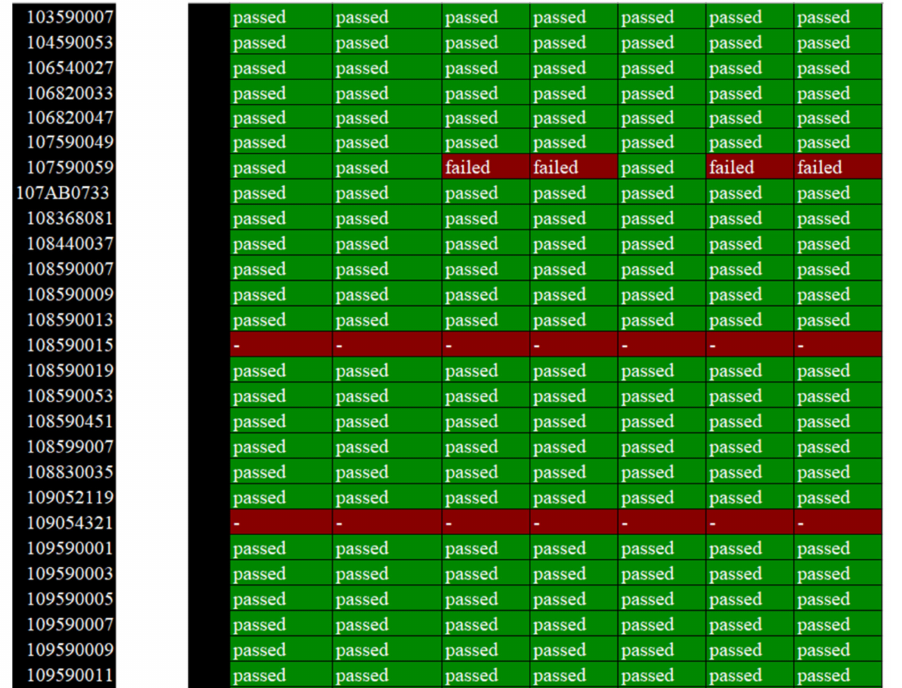
Figure 34. Results of the students’ programming